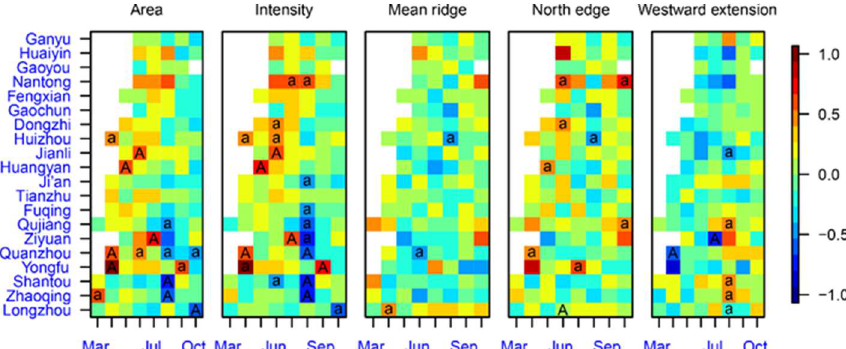
Figure 4. Monthly correlation coefficients between cumulative light-trap catches of WBPHs (after log transformation) at the 20 PPS sites and WPSH indices. Sites are listed geographically, from north to south, and positive and negative correlations significant at the 1% and 5% levels are labeled with ‘A’ and ‘a’, respectively.